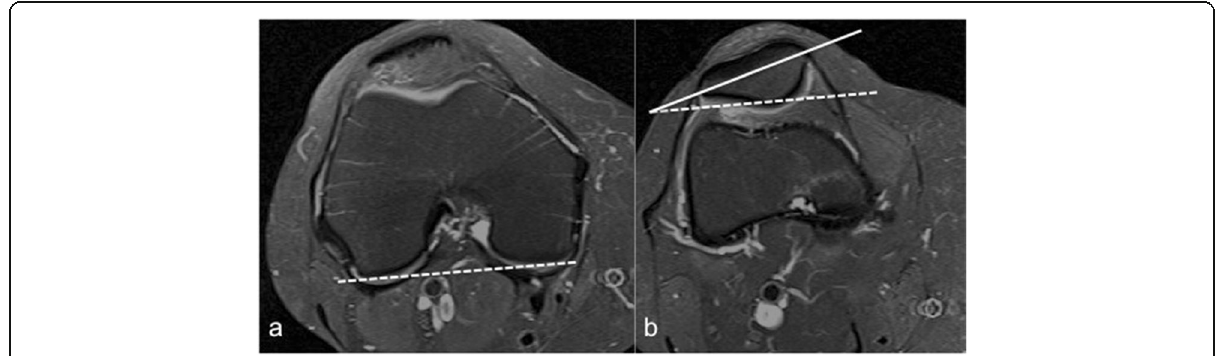
Fig. 6 Patellar tilt assessment. a The posterior condylar line is drawn on the slice where the posterior femoral condyles are largest (dashed line). b The patella tilt angle is measured between the posterior condylar line (dashed line) and the maximal patella width (solid line).